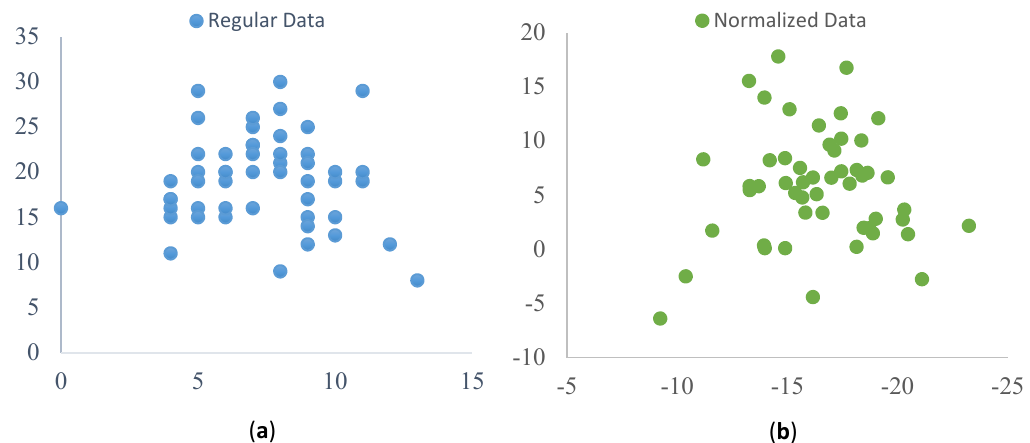
Figure 11. ( a ) Regular data, ( b ) Normalized data. Axis values are two feature values before ( a ) and after ( b ) normalization.